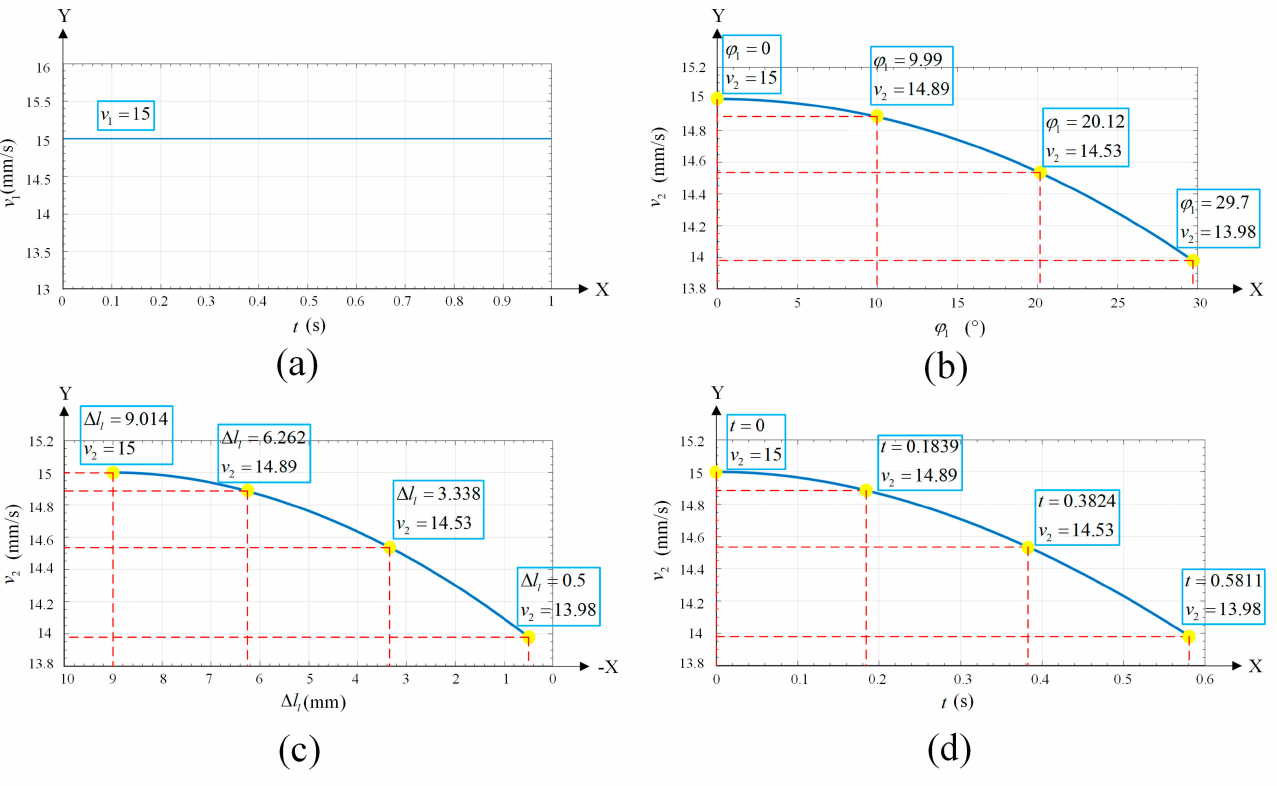
Figure 12. ( a ) The velocity curve before planning and the velocity is always 15 mm/s. ( b ) The velocity- ϕ 1 curve after planning. ( c ) The velocity- ∆ l l curve after planning. ( d ) The actual velocity curve after planning. The highlighted points in the figures represent the same states of inclination during the weaving welding